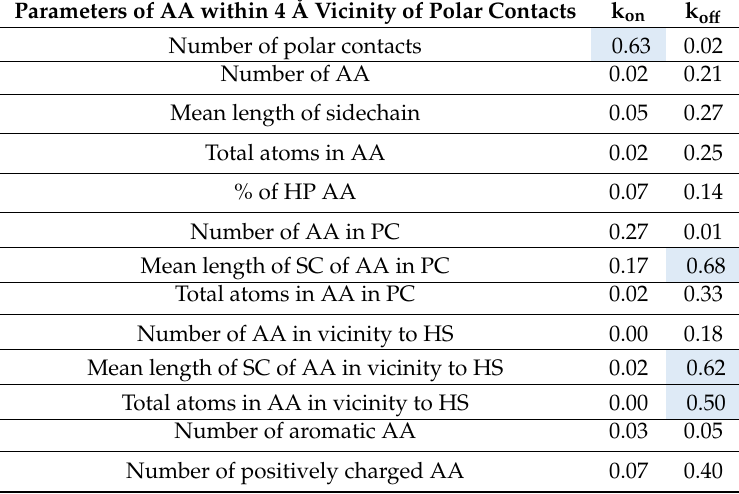
Table 3. Analysis of kinetic parameters of aptamer–protein complexes. The values of coe ffi cient of determination, R 2 , for the logarithmic regression curves for the dependencies of di ff erent structural parameters versus kinetic constants of association (k on ) and dissociation (k o ff ). The strongest correlations are